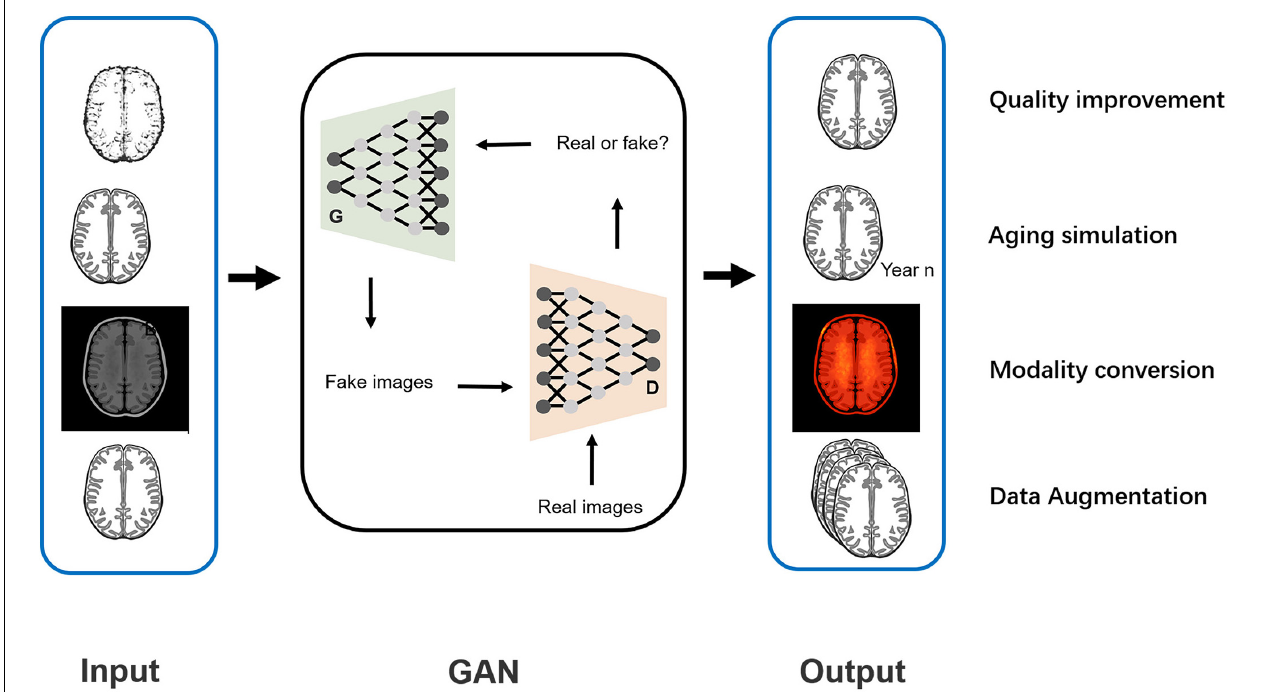
FIGURE 10 | Schematic diagram of the function of image processing using